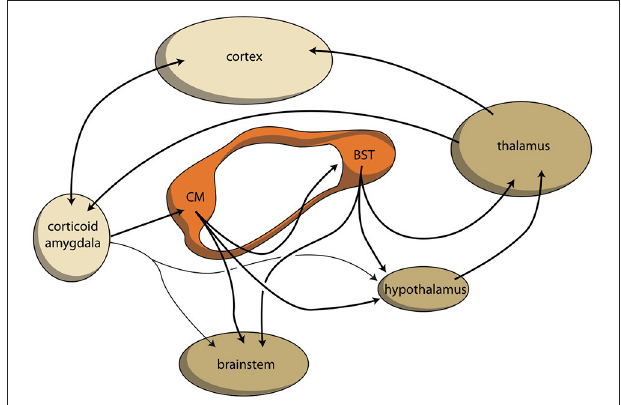
FIGURE 5 | Limbic cortical-subcortical regulatory circuit. BST, bed nucleus of the stria terminalis; CM, centromedial amygdala; orange, extended amygdala; dark yellow, diencephalon, and brainstem; light yellow, corticoid amygdala, and